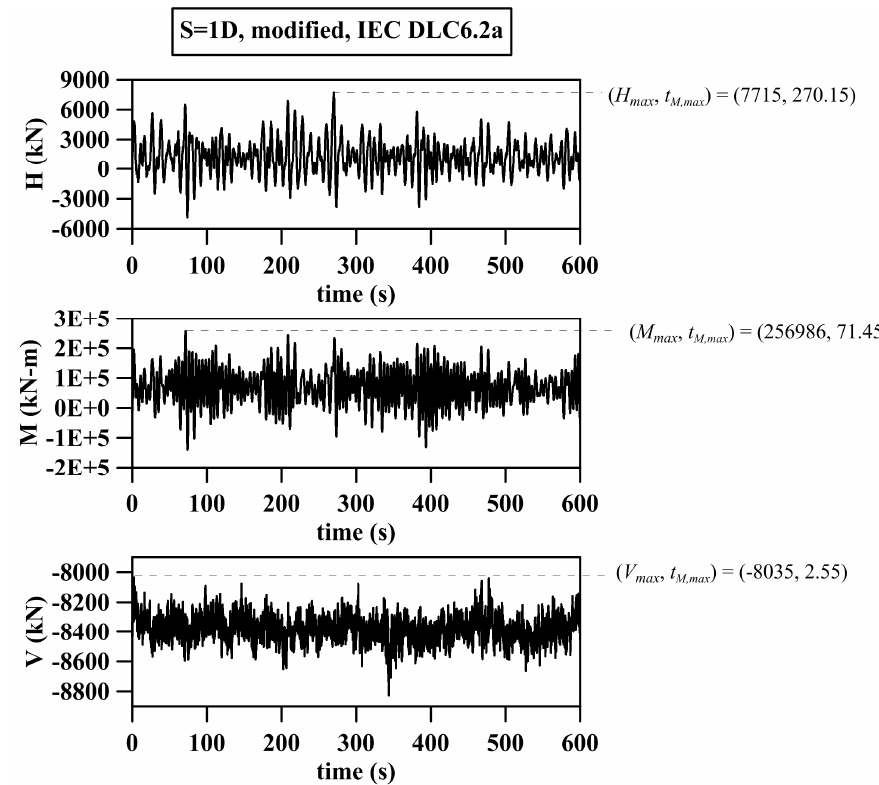
Figure 11. Loading time-series at pile head after scour occurred; ( H, M max , V ) t =71.45s = (5925 kN, 256,986 kN-m, − 8304 kN).